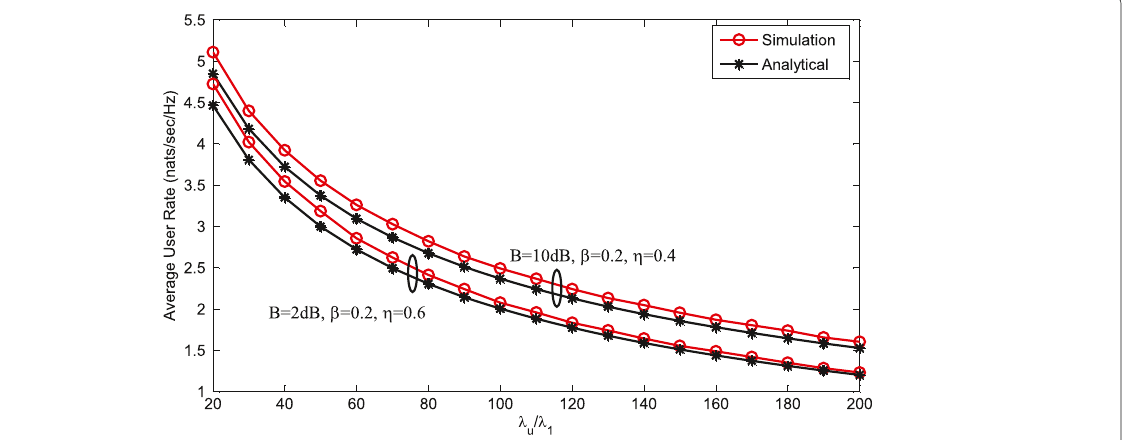
Fig. 2 Validation of the analytical results for average user rate via Monte Carlo methods with T FR,1 = T FR,2 = − 10